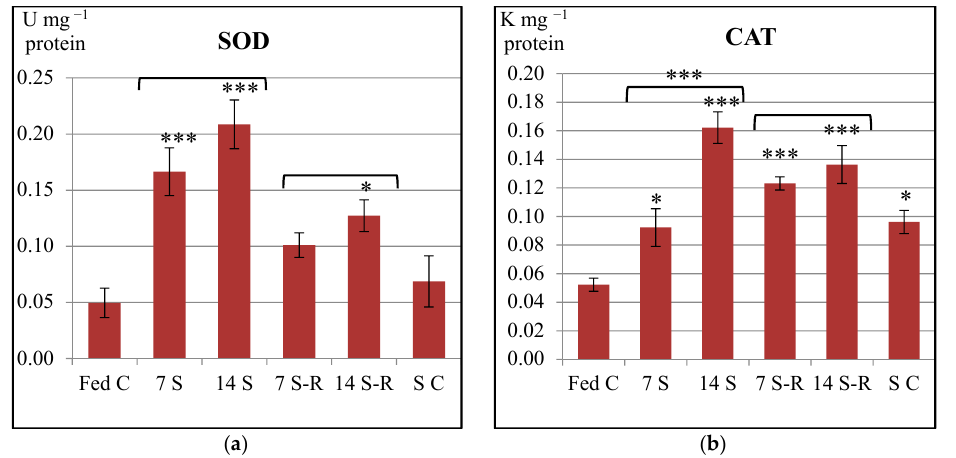
Figure 1. Specific activities of antioxidant enzymes in the intestine of Acipenser stellatus juveniles subjected to different starvation/refeeding regimes. ( a ) Superoxide dismutase (SOD) specific activity; ( b ) catalase (CAT) specific activity. The data are illustrated as average value of the groups (n = 8) ± standard error of the mean (SEM). All data were statistically analyzed using one way—ANOVA. Statistical significance: * p < 0.05; *** p < 0.001; the statistical significance of the changes is related to the fed control level and it is also presented between 7 S and 14 S groups and between 7 S-R and 14 S-R groups. Fed C—fed control group; 7 S—group starved for 7 days; 14 S—group starved for 14 days; 7 S-R—group starved for 7 days and refed 21 days; 14 S-R—group starved for 14 days and refed 21 days; S C—starved control.